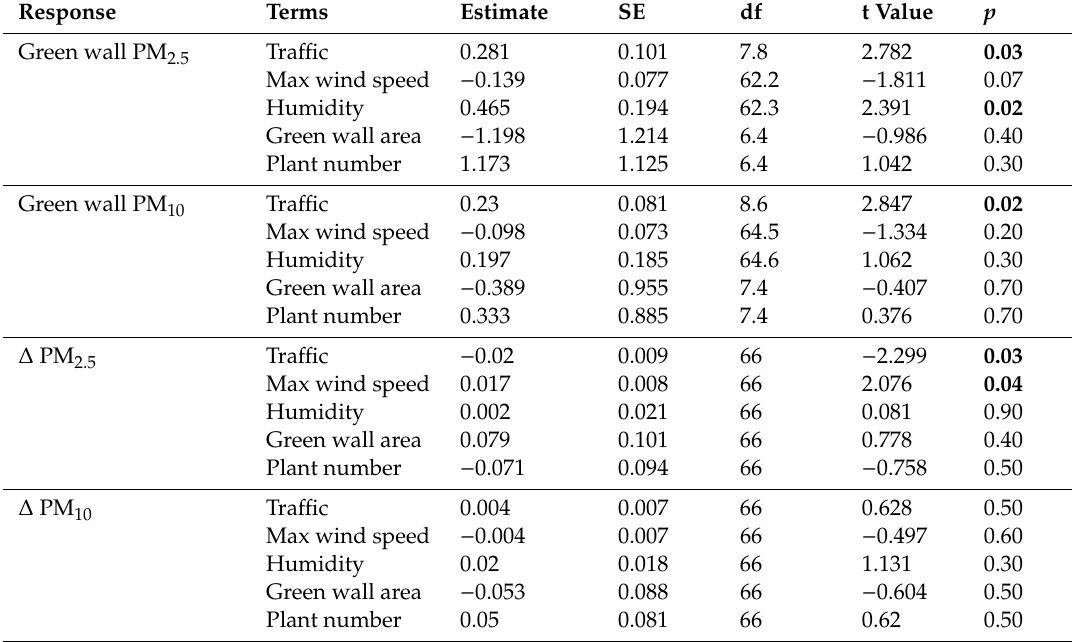
Table 2. Results from multiple regression LMMs of green wall PM 2.5 and PM 10 , ∆ PM 2.5 , and ∆ PM 10 . Bold p values indicate significant